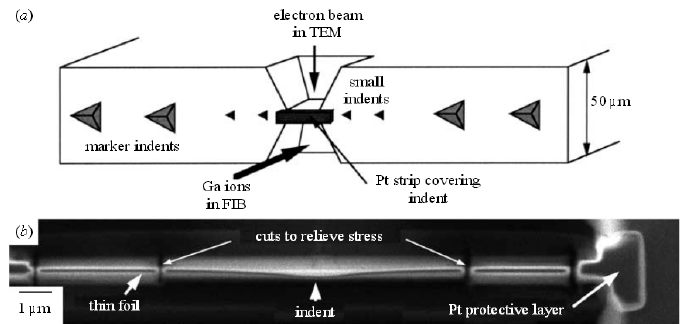
Figure 12. ( a ) Schematic illustrating how the indents were sectioned in the FIB to allow examination with a TEM; ( b ) Secondary electron FIB image of the final stages of preparation of a thin foil through a 50 mN indent in silicon [42]. Reproduced with permission from S.J. Lloyd et al., Proceedings of the Royal Society A; published by The Royal Society,